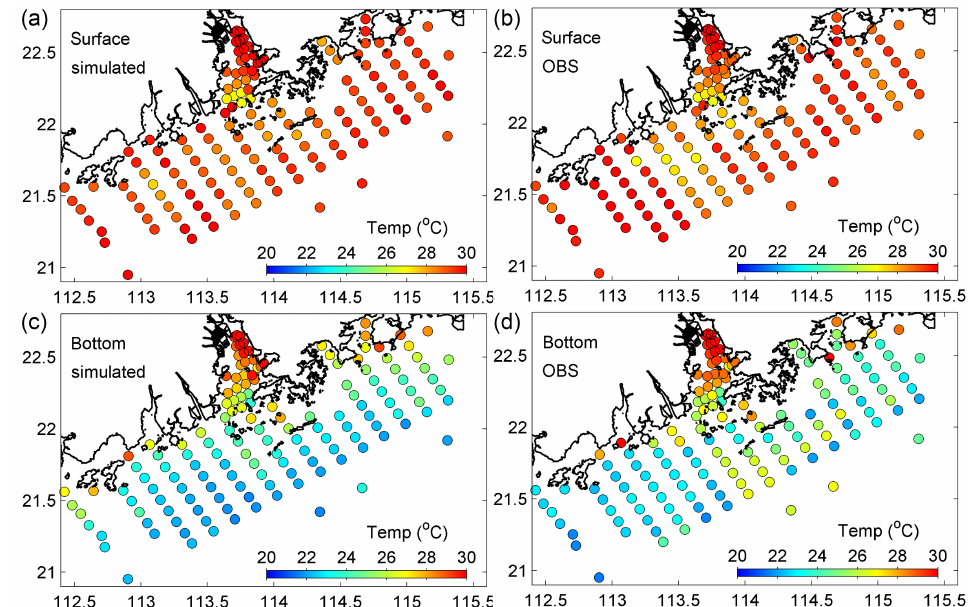
Figure 6. Comparisons of the simulated (left panels) and the observed (right panels) temperature at the surface layer (upper panels) and the bottom layer (lower panels) during July and August